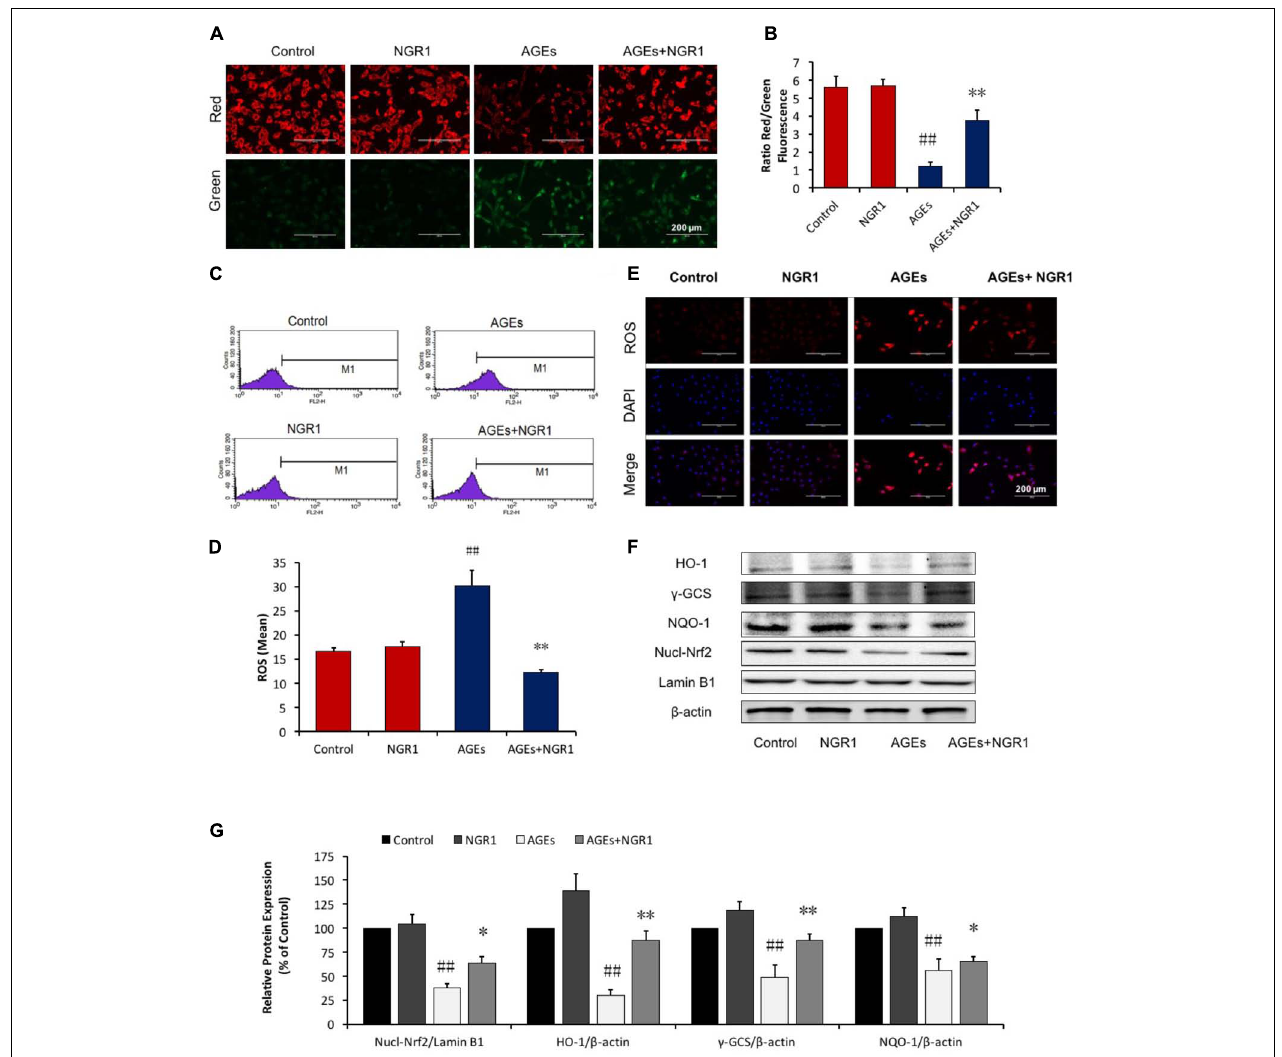
FIGURE 2 | NGR1 inhibits mitochondrial membrane depolarization and intracellular ROS in H9c2 cardiomyocytes induced by AGEs. (A,B) Representative images and bar graphs of JC-1 red/green cells and merges showed that NGR1 increased the ratio of red to green fluorescence intensity. (C) Intracellular ROS levels and statistical analysis. (D) in H9c2 cardiomyocytes evaluated using a flow cytometer, M1 represents ROS positive cell proportion. (E) Representative images of MitoSOX red staining. The bar represents 200 µ m. (F) Immunoblotting analysis of Nrf2-mediated anti-oxidative enzymes in H9c2 cells. (G) The relative protein expression of Nucl-Nrf2, HO-1, γ -GCS, and NQO-1 compared to β -actin are expressed in the bar graphs. The quantitative data are presented as the mean ± SD of three independent experiments. ## P < 0.01 vs. the Control group, ∗ P < 0.05 or ∗∗ P < 0.01 vs. the AGEs